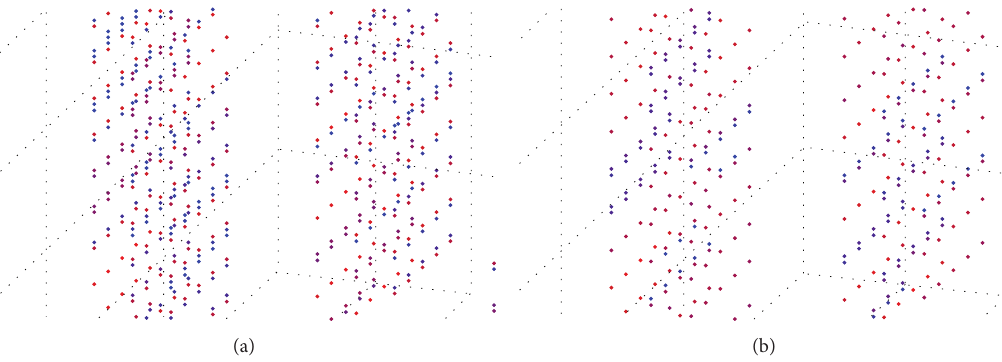
Figure 9: The magnified imaging results with (a) the SC-MOCO method and (b) the proposed JMC-MOCO method.